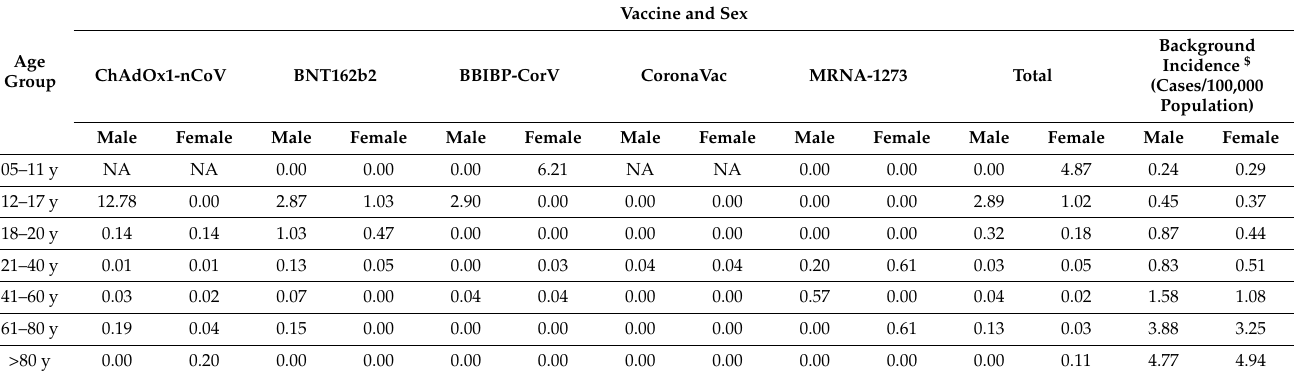
Table 2. Rate of suspected myocarditis/pericarditis (per 100,000 doses administered) by vaccine, age, and sex ( n =